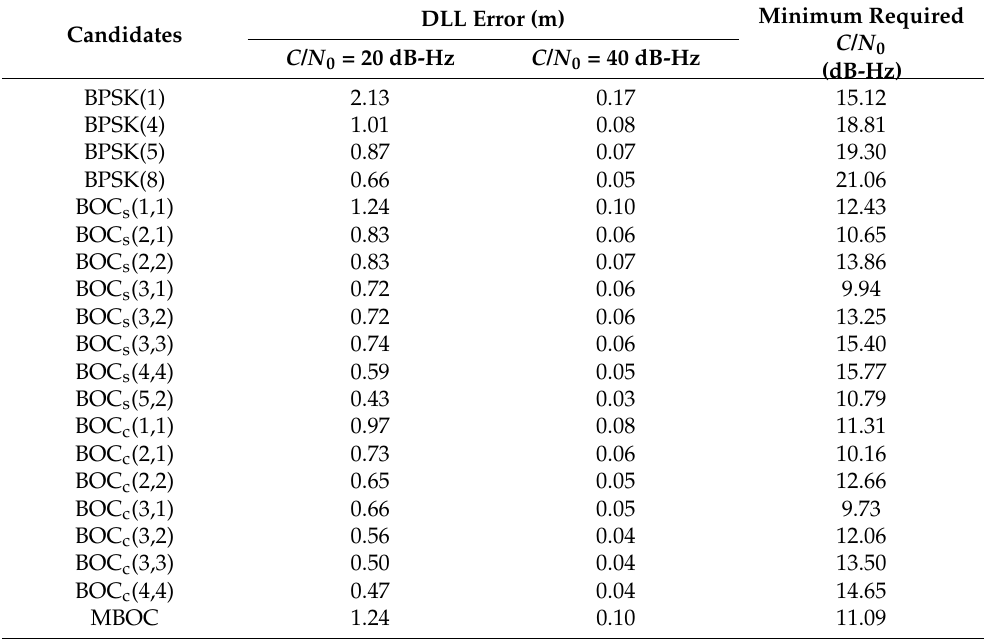
Table 7. The DLL error and minimum required carrier-to-noise density ratio ( C / N 0 ) for stable DLL tracking of the candidates.